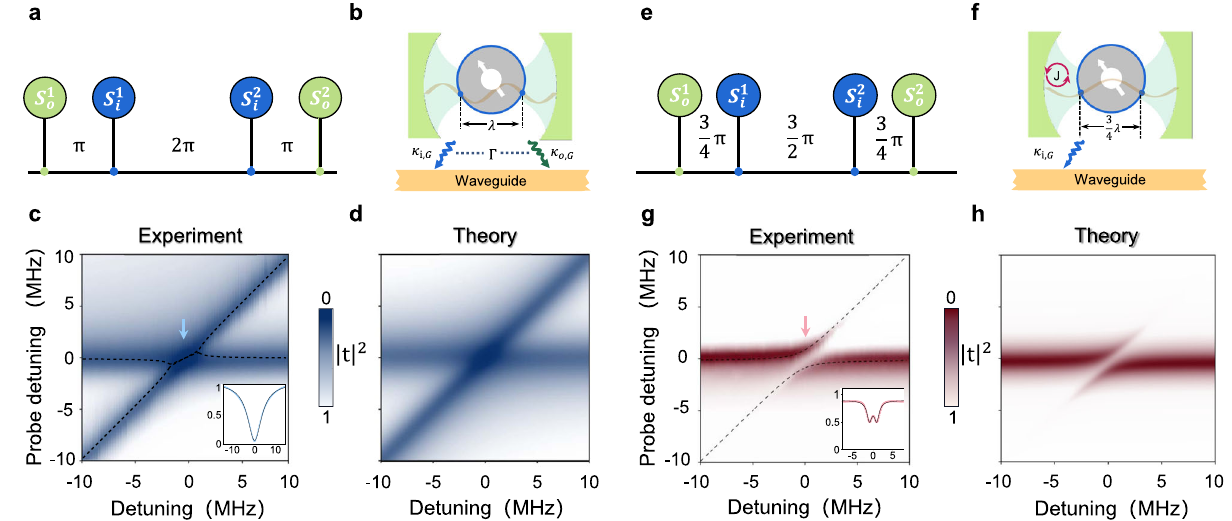
Fig. 4 | The equivalent model of the nested two giant spin ensembles, and the spectroscopy studies. a , e Sketch of the propagating phase between the two coupling points of the inner (outer) sphere in the cases of purely dissipative cou- pling ( a ) and purely coherent coupling ( e ), respectively. b , f Schematic of the analogous coupled system. The coupling points of the outer GSE work as two mirrors to form a cavity. The inner YIG sphere (blue) and the cavity collectively radiate into the waveguide ( b ), leading to the dissipative coupling between the innerand outer GSEs.The outerYIG spheredecouplesfrom the waveguide ( f ),and coherentcouplingbetweentheinnerandouterGSEsisobtained. c , g Transmission